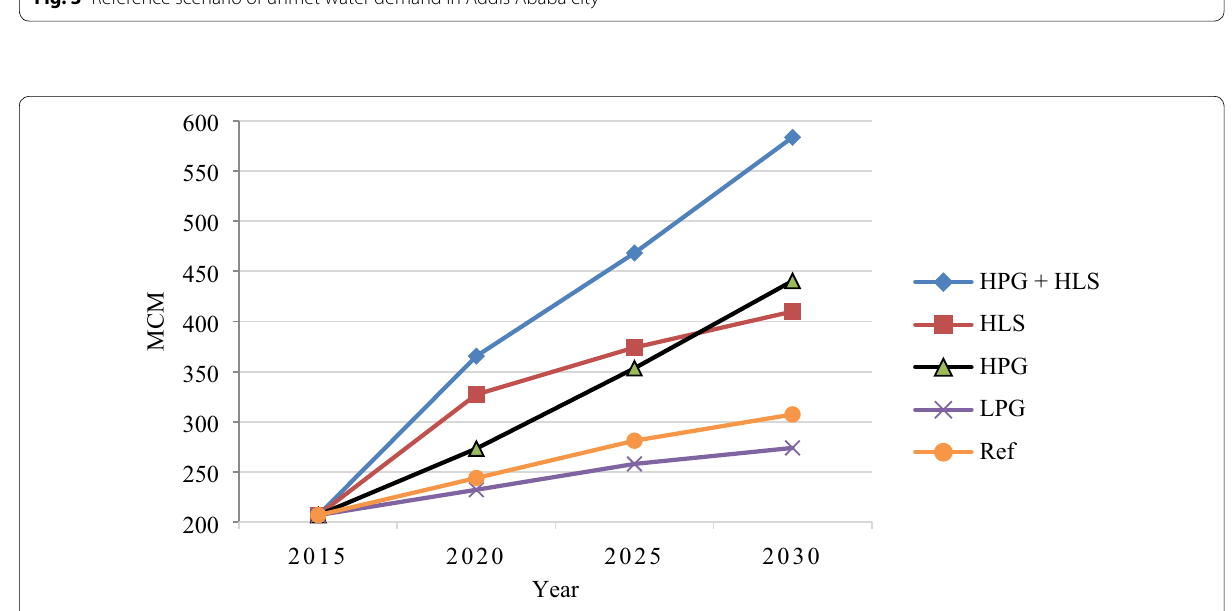
Fig. 3 Reference scenario of unmet water demand in Addis Ababa city